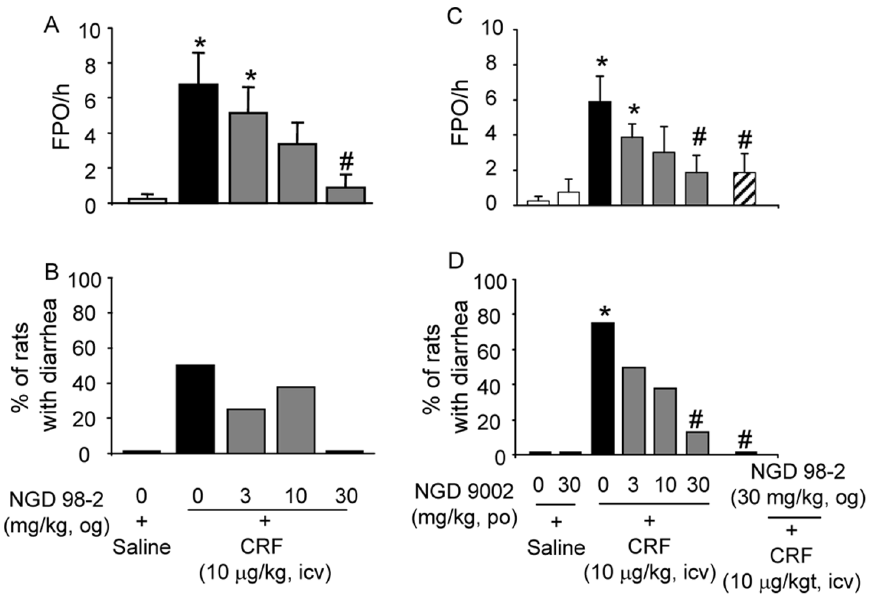
Figure 3. Oro-gastric (og) administration of CRF 1 antagonist, NGD 98-2 or NGD 9002 blunts icv CRF-induced defecation and diarrhea in rats with chronic icv cannula. NGD 98-2 (3, 10 and 30 mg/kg) or saline was given og 180 min before icv CRF or saline and fecal output (A) and diarrhea (B) were monitored for 1 h post icv injection. NGD 9002 (3, 10, 30 mg/kg) or saline was given 60 min before icv CRF and FPO (C) and diarrhea (D) monitored for 1 h post icv injection. Each bar in A and C represents the mean and SEM while each bar in B and D represents mean % of 8 rats/group. *p , 0.05 compared with og vehicle + icv saline group (A-D); # p , 0.05 compared with og vehicle + icv CRF (A-D), ANOVA, Student-Newman-Keuls; t-test; Fisher Exact